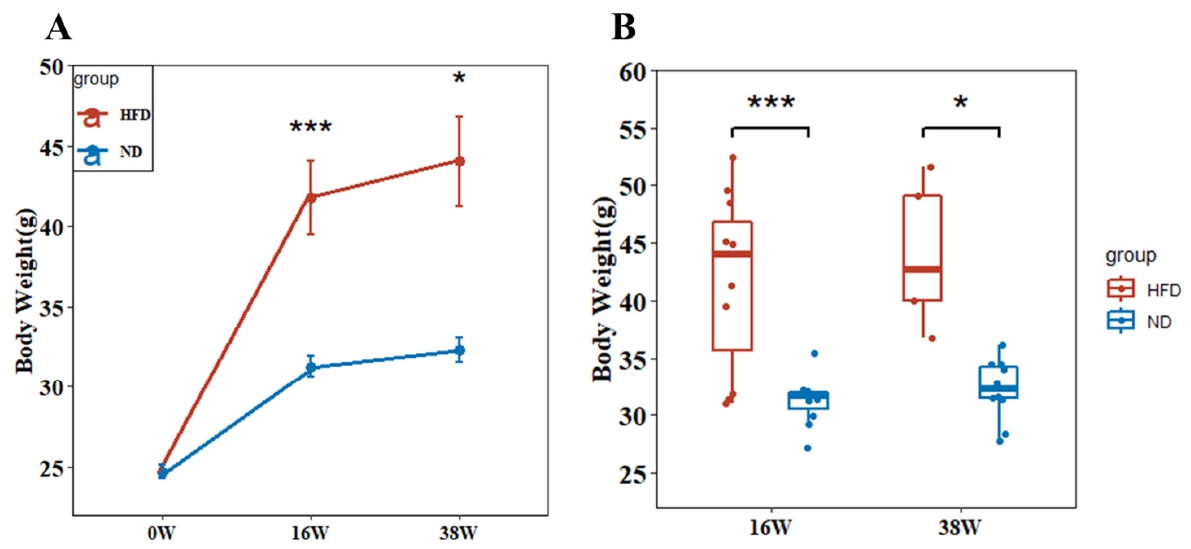
Figure 1. Mouse body weight. ( A ) Body weight curves of mice in each group were recorded during the experiment. ( B ) The HFD group exhibited a significantly higher body weight gain after 38 weeks of a high-fat diet compared to the ND group. (* p < 0.05, *** p < 0.001).